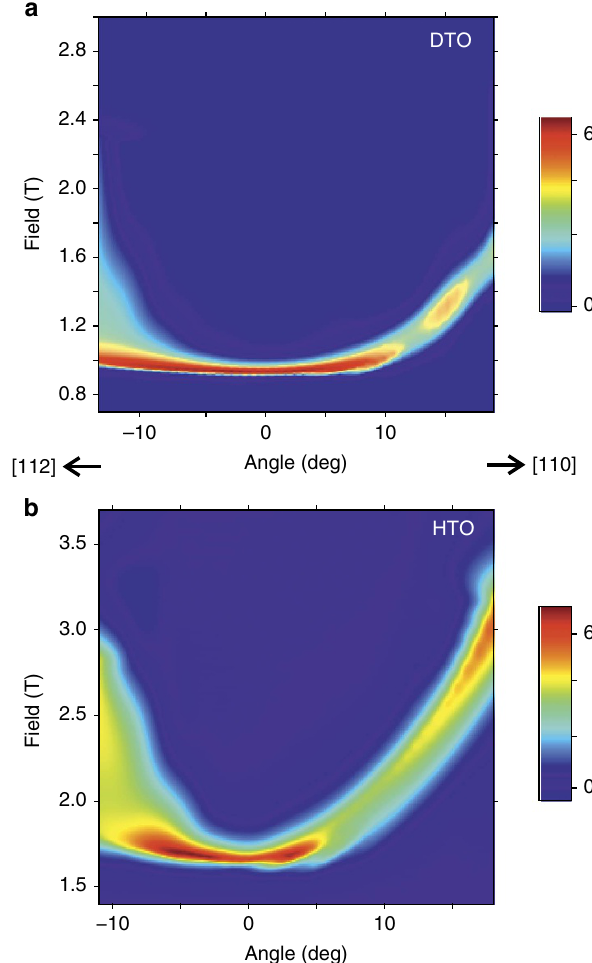
Figure 2 | Contour plots of the magnetic susceptibility for DTO and HTO. ( a,b ) Interpolated contour plot of the magnetic susceptibility, for DTO and HTO respectively, at T ¼ 0.18K. Each graph is constructed based on approximately 40 traces of w versus angle at fixed temperature and field. Positive (negative) angles correspond to a rotation towards [110] ([112]).